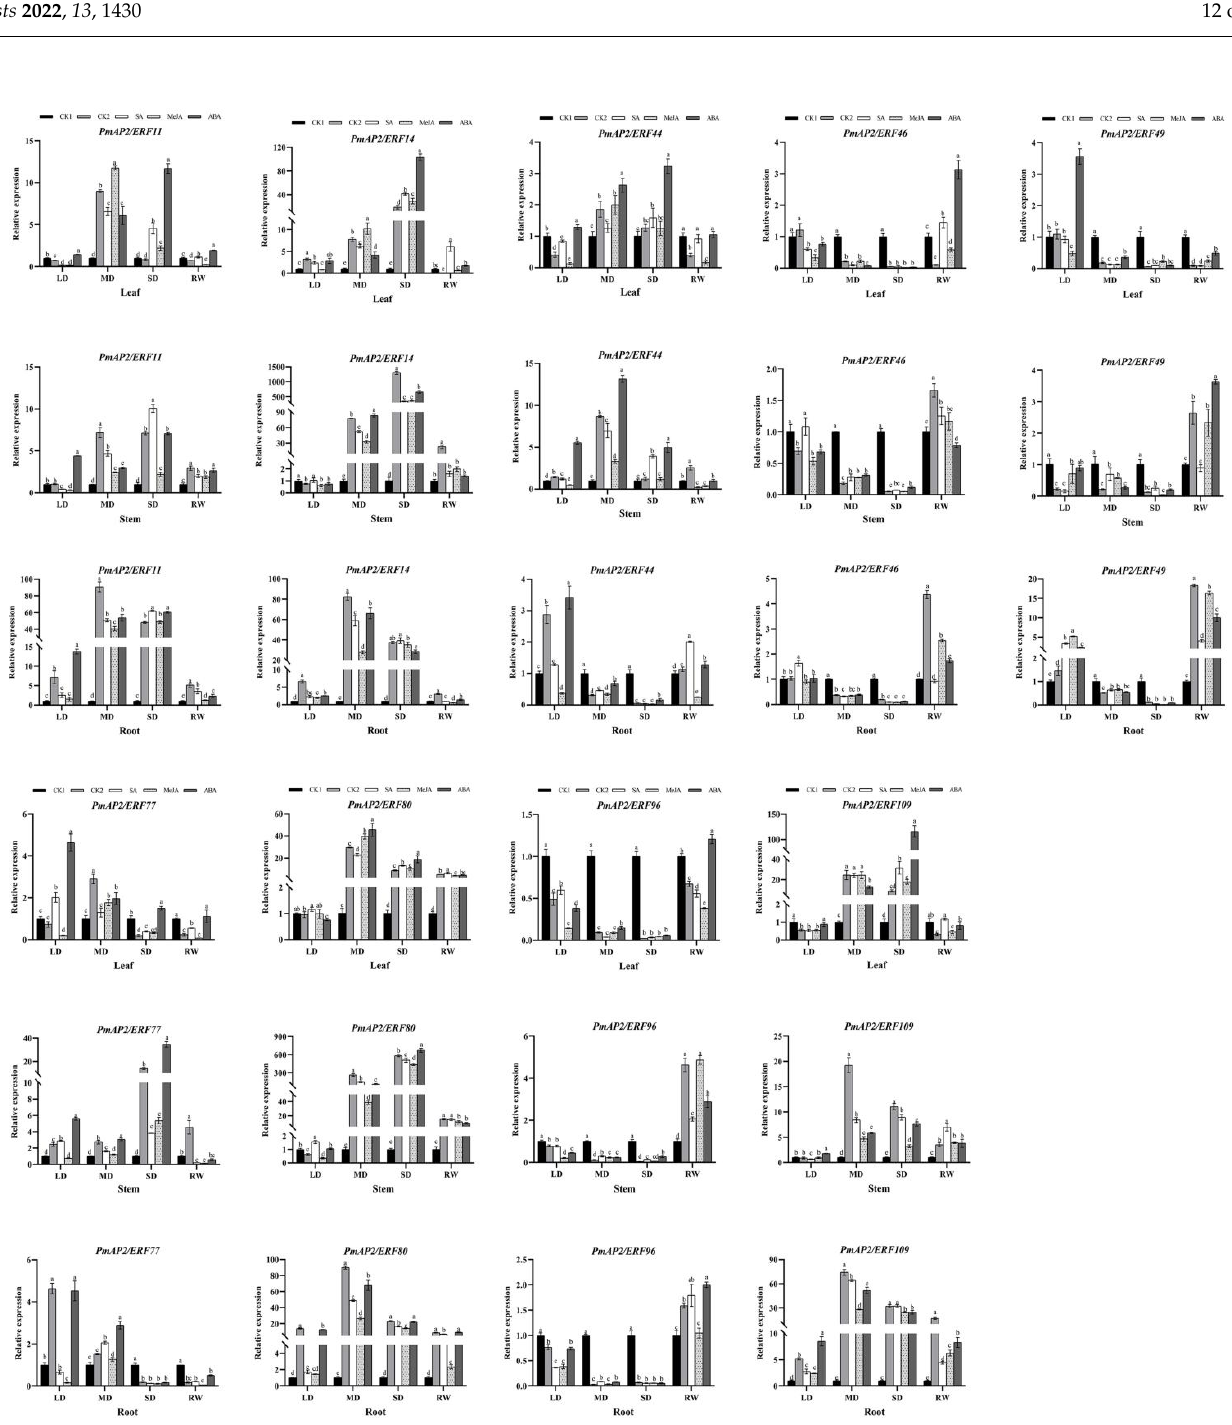
Figure 7. Expression patterns of PmAP2/ERF genes in drought-sensitive lines during drought stress. LD indicates light drought, MD indicates moderate drought, SD indicates severe drought, and RW indicates rehydration. Different lowercase letters indicate differences in gene expression at the p < 0.05 level between treatments at each sampling site. The standard error of the mean for three biological replicates is represented by the error bars.